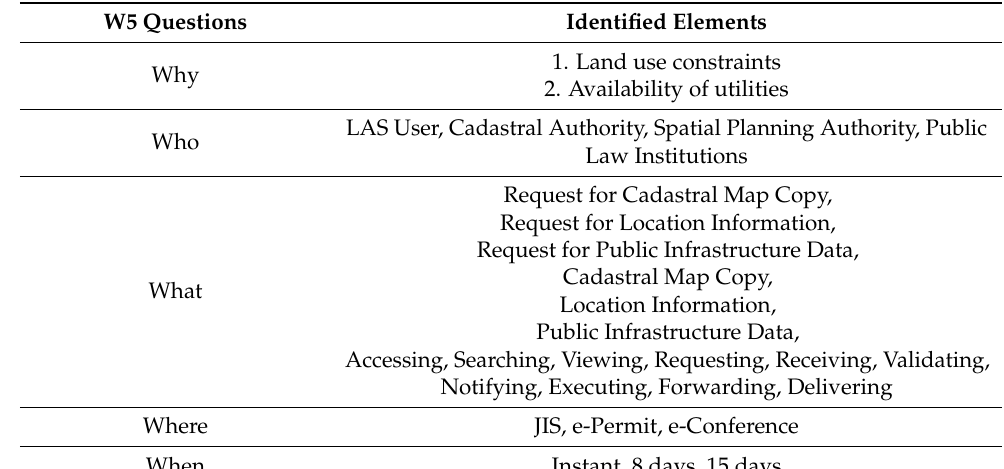
Table 1. W5 analysis of the formalized processes.